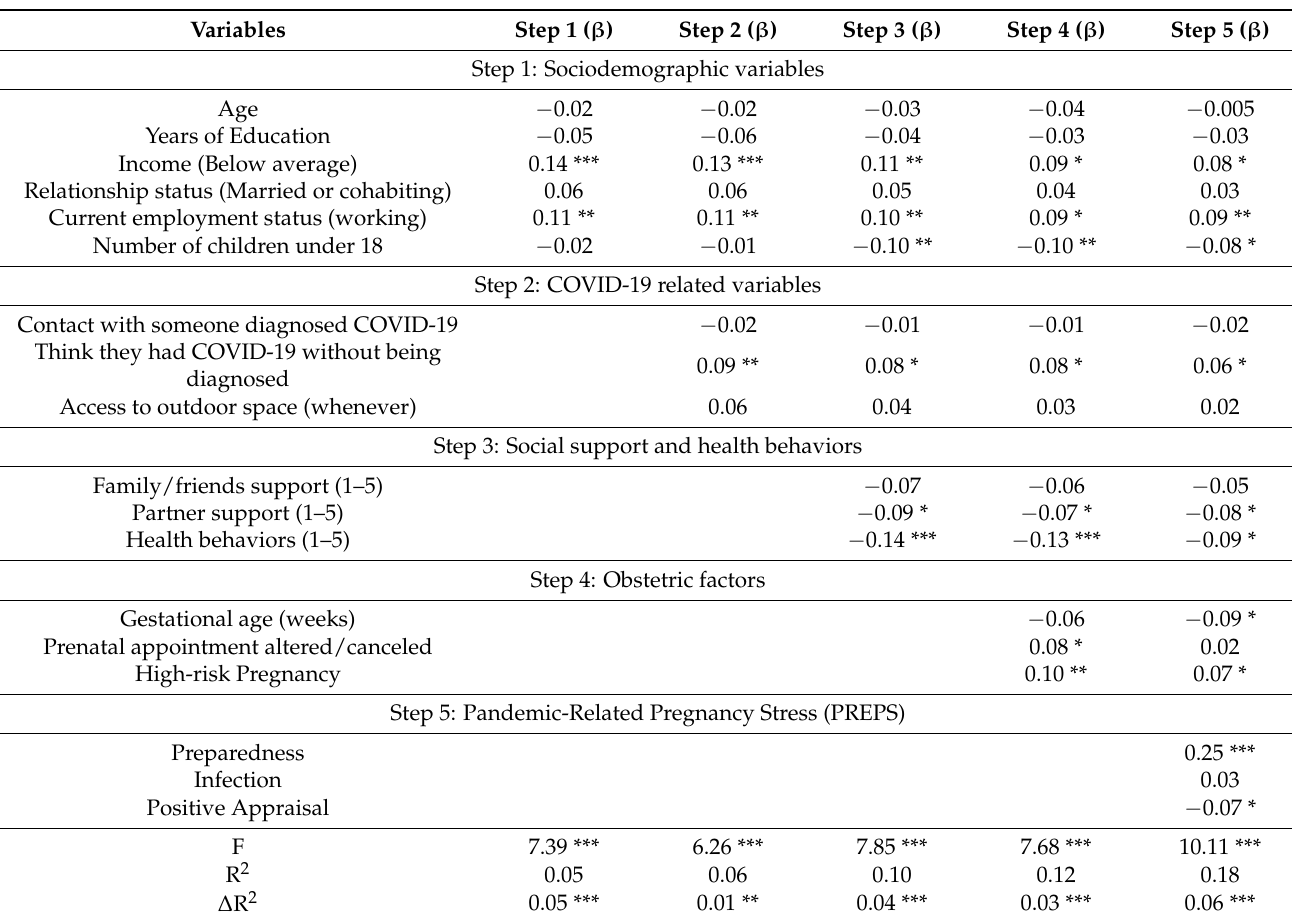
Table 3. Multiple hierarchical linear regression analyses—prediction of depression (PHQ-2) score among pregnant